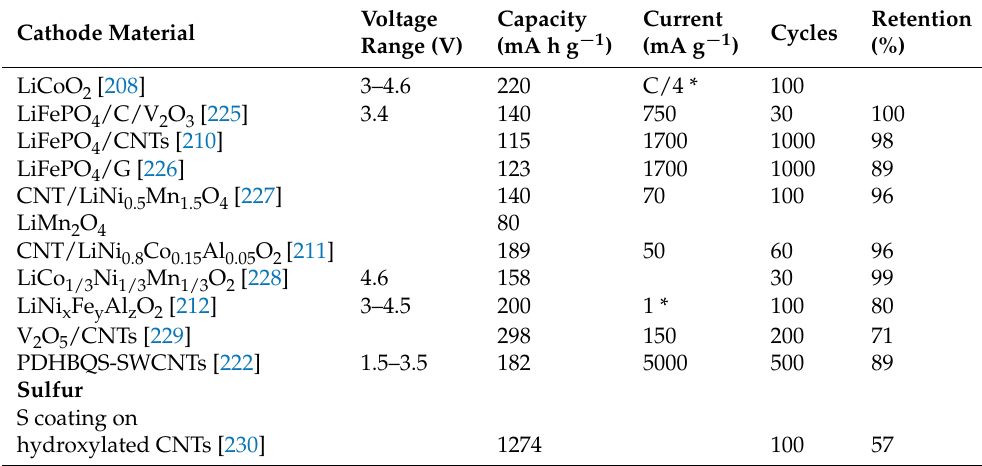
Table 8. Cathode materials for Li-based